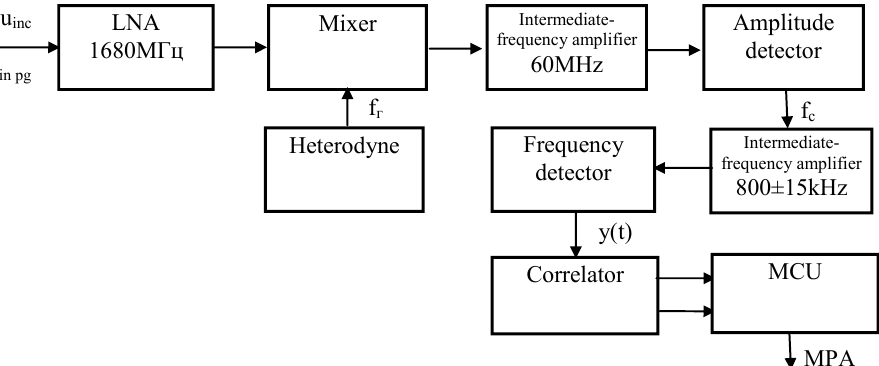
Fig. 2. Block diagram of the telemetry channel radar receiving